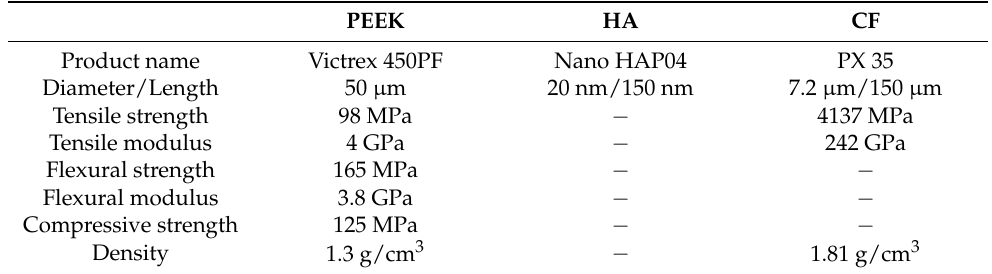
Table 1. Properties of materials.